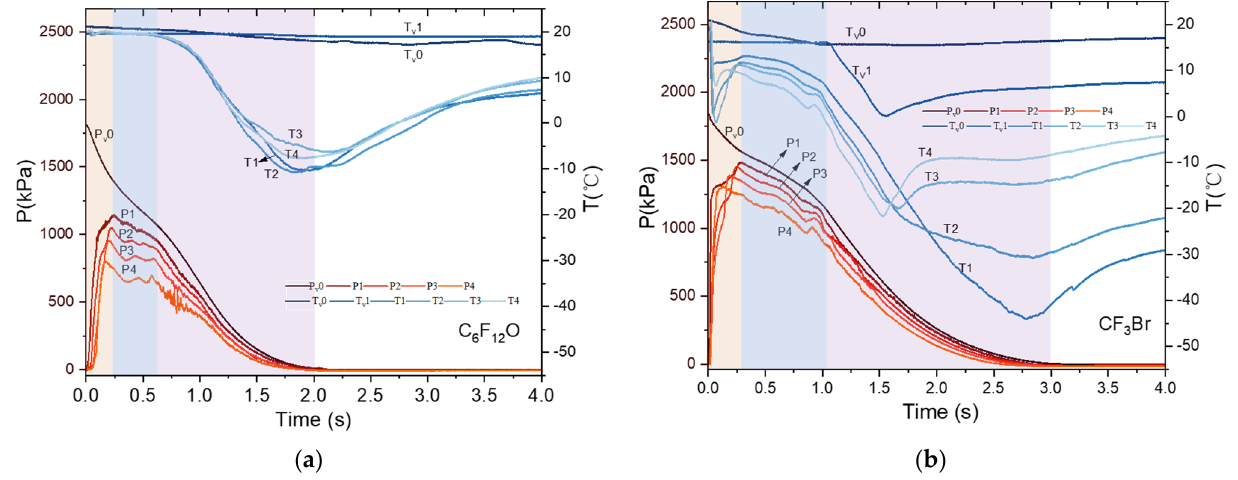
Figure 2. Pressure and temperature pro fi les versus time in the tests: ( a ) C 6 F 12 O and ( b ) CF 3 Br.